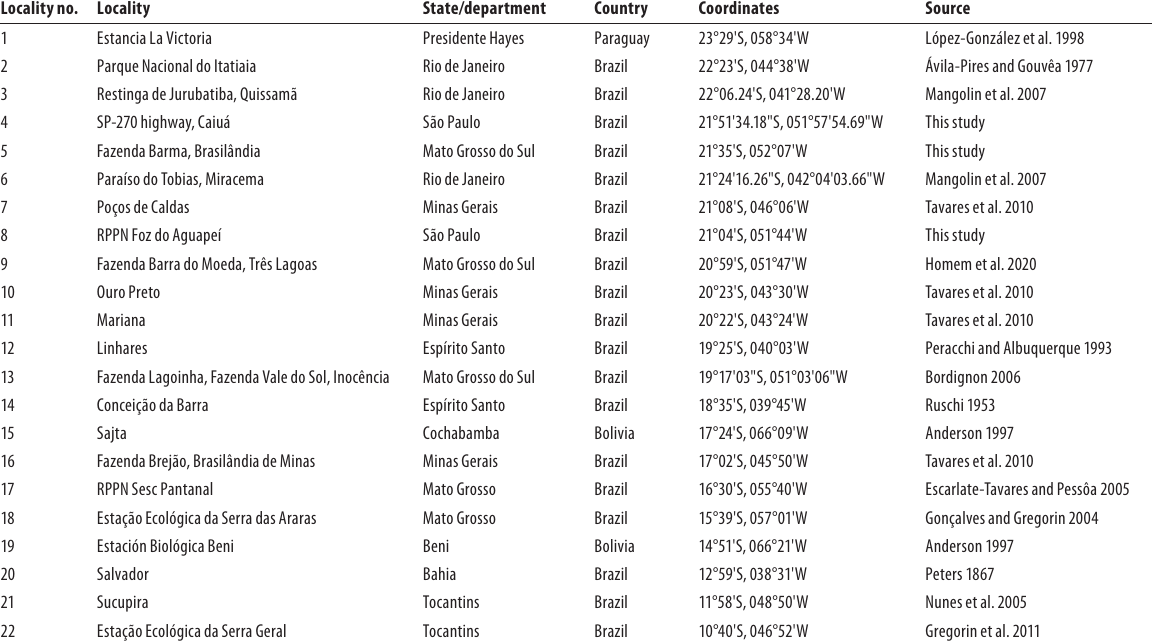
Table 1. Southernmost localities of Lophostoma brasiliense . The “Locality number” field correspond to localities in Figure 1. Locality no.